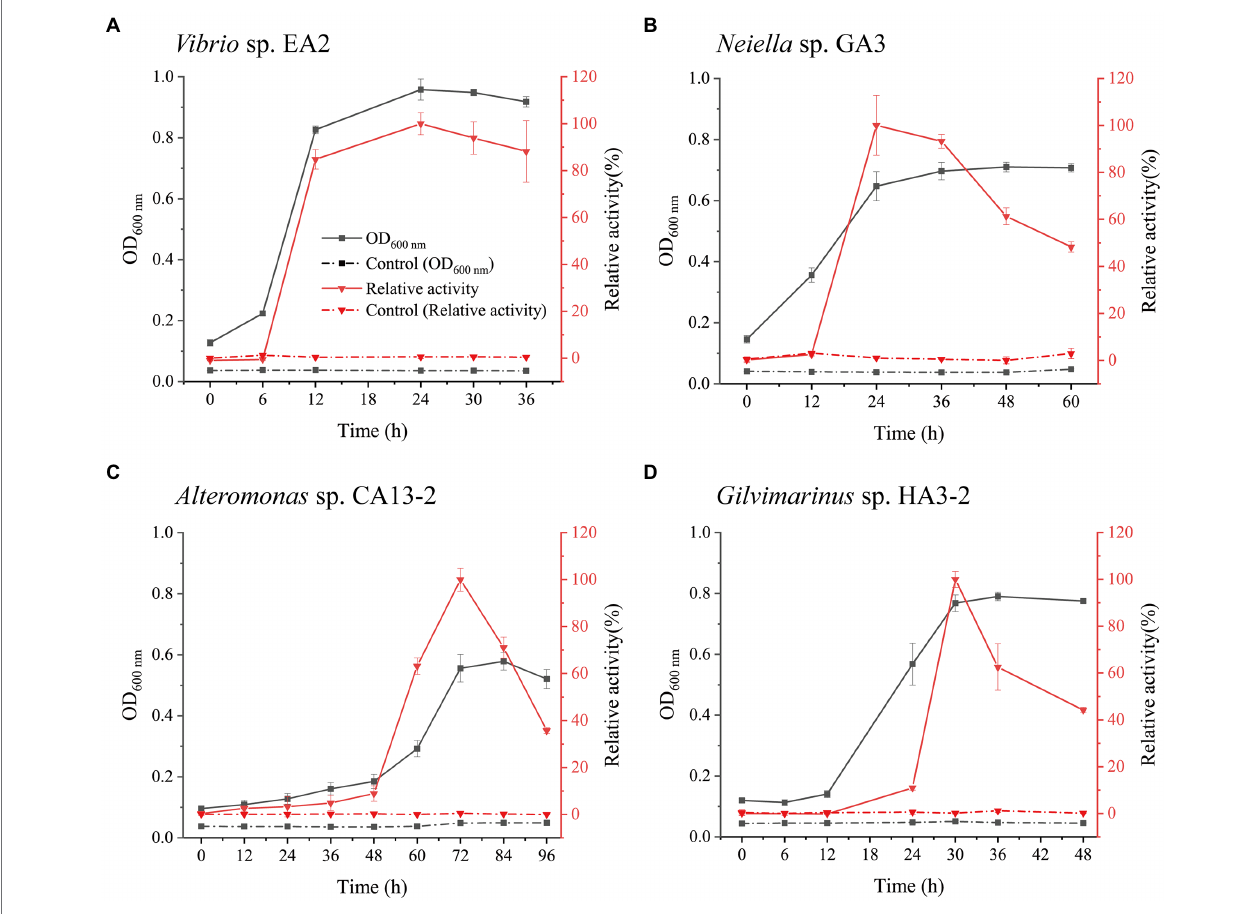
FIGURE 4 | Growth and the extracellular 1,3-xylanase activities of Vibrio sp. EA2 (A) , Neiella sp. GA3 (B) , Alteromonas sp. CA13-2 (C), and Gilvimarinus sp. HA3-2 (D) cultured with 0.2% 1,3-xylan as the carbon source. The 1,3-xylanase activities were determined at 30 ° C in PBS (pH 7.0), and the highest activity was taken as